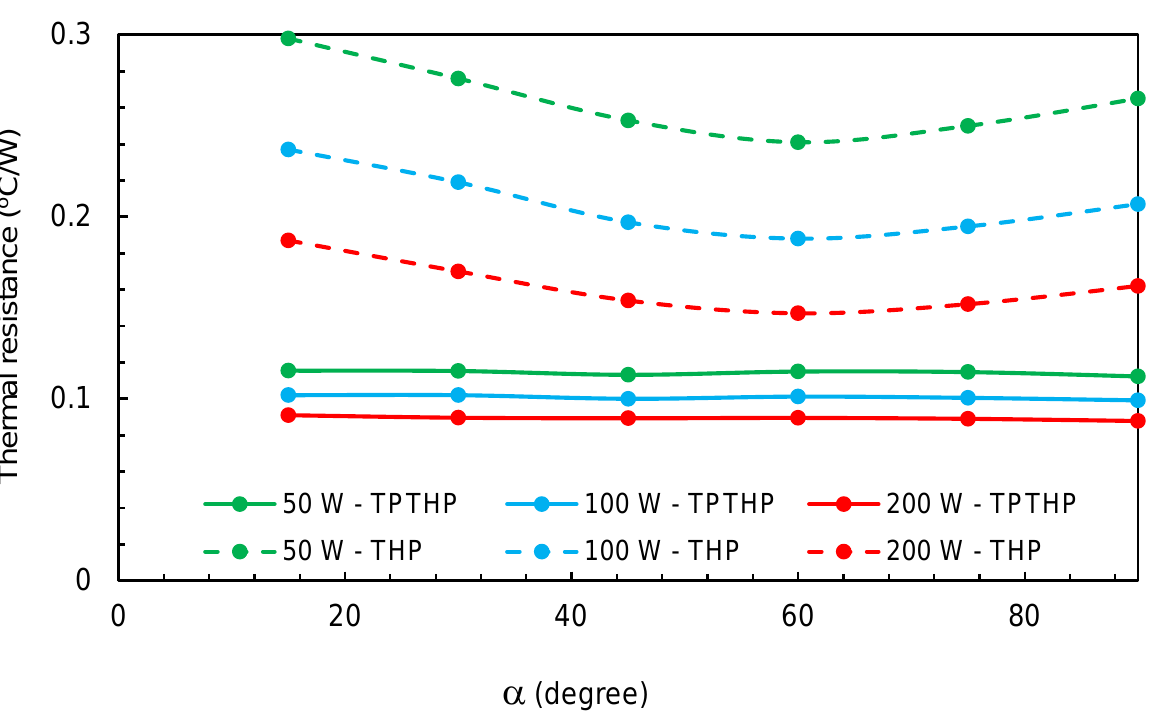
Figure 11. Thermal resistance variation with inclination angle for the TPTHP and THP (FR = 40%).